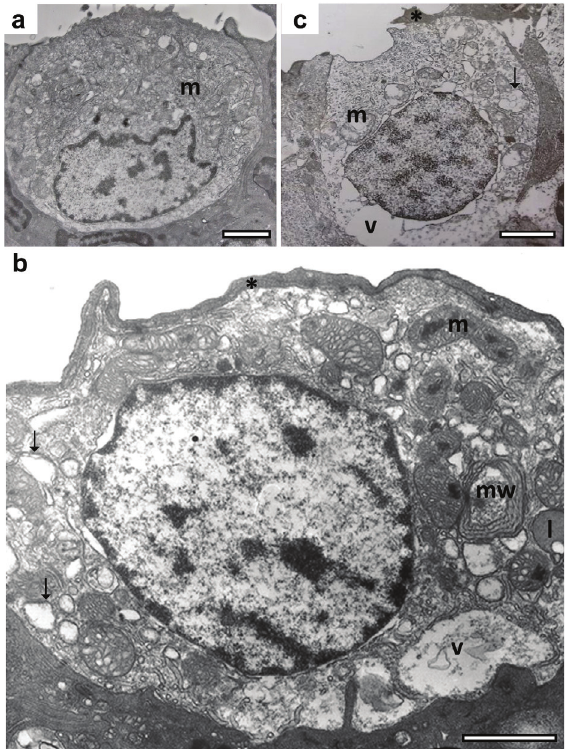
Figure 3 - TEM of MRCs from lamellae of C. macropomum . a. Control group. b. 0.04 mM NO 2- . c. 0.2 mM NO 2- . Hypertrophic MRCs were filled with distend and dense mitochondria (m), distend tubular system (arrow), lysosome-like bodies (l), myelin whorls (mw) and large vacuoles (v). * = extension of pavement cell. Scale bars: a, c = 1  m; b = 5  m.